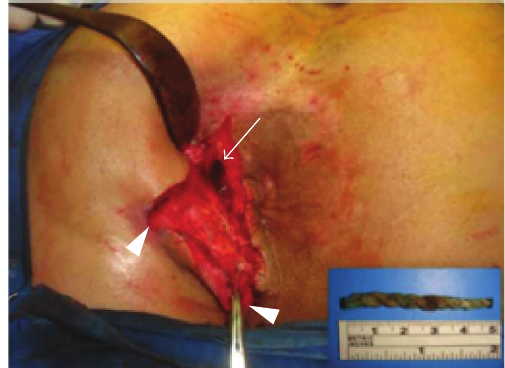
Figure 2: Intraoperative view of the external openings of the fistula in ano (arrow-heads) and the upper part of the tract where the foreign material resided (arrow). The extracted nonabsorbable braided thread is shown in the inlet figure.